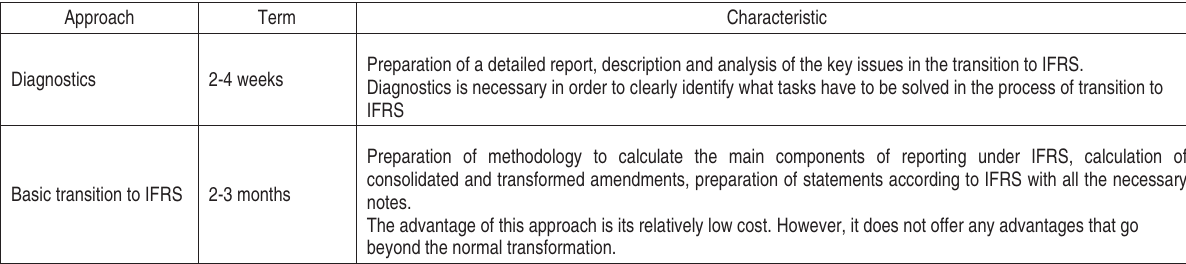
Table 3. Approaches to the transformation of the reporting regarding the timing and